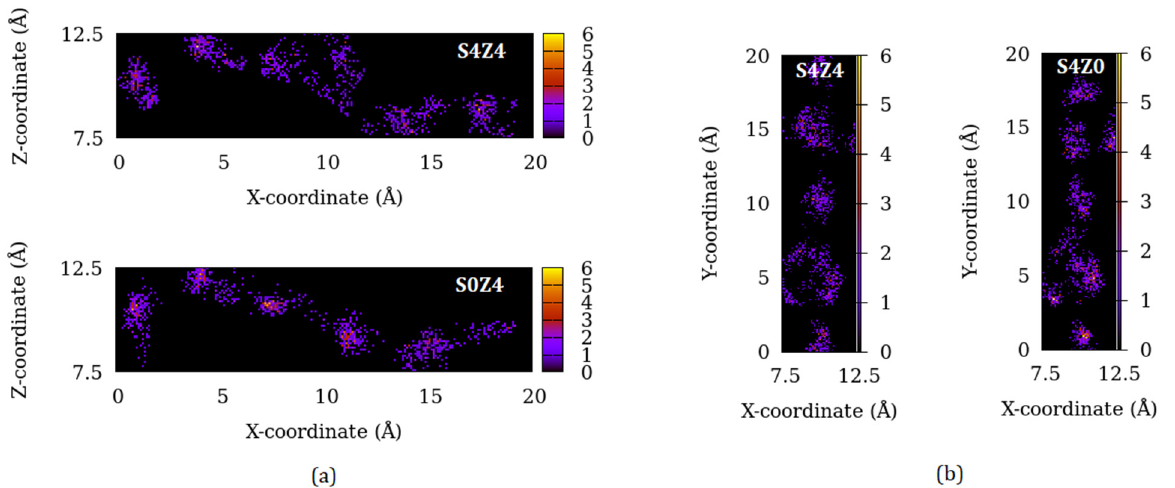
Figure 9. Distribution of the center of mass of CO 2 molecules adsorbed in ( a ) zigzag and ( b ) straight channels of unmodified silicalite (S4Z4) and silicalite with all straight (S0Z4) and zigzag (S4Z0) channels blocked. The intensity corresponds to the number of fluid molecules found at a location in 200 configurations of the system.